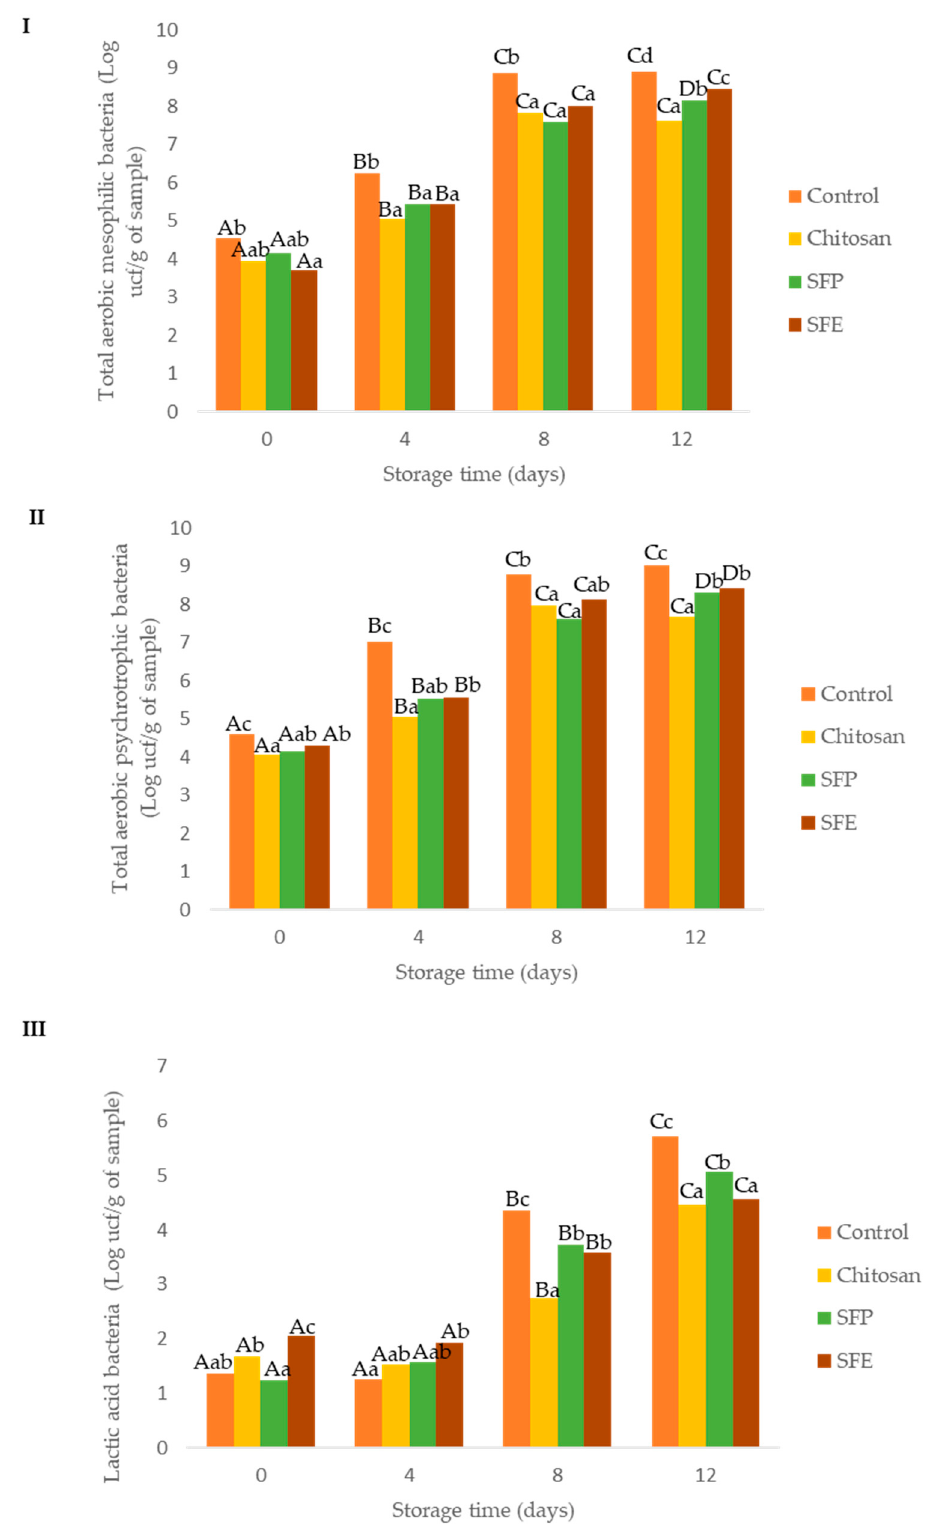
Figure 2. E ff ect of edible films on the growth of total aerobic mesophilic ( I ), total aerobic psychrotrophic ( II )andlacticacid( III )bacteriainAtlantichorsemackerelburgerscoatedwithdi ff erentfilmformulations (control without coating film, chitosan, sea fennel plant (SFP) incorporated in a chitosan-based film and sea fennel extract (SFE) incorporated in a chitosan-based film) and stored at 4 ◦ C for 12 days. Di ff erent uppercase letters indicate significant di ff erences ( p < 0.05) over storage in each treatment. Di ff erent lowercase letters indicate significant di ff erences ( p < 0.05) due to the